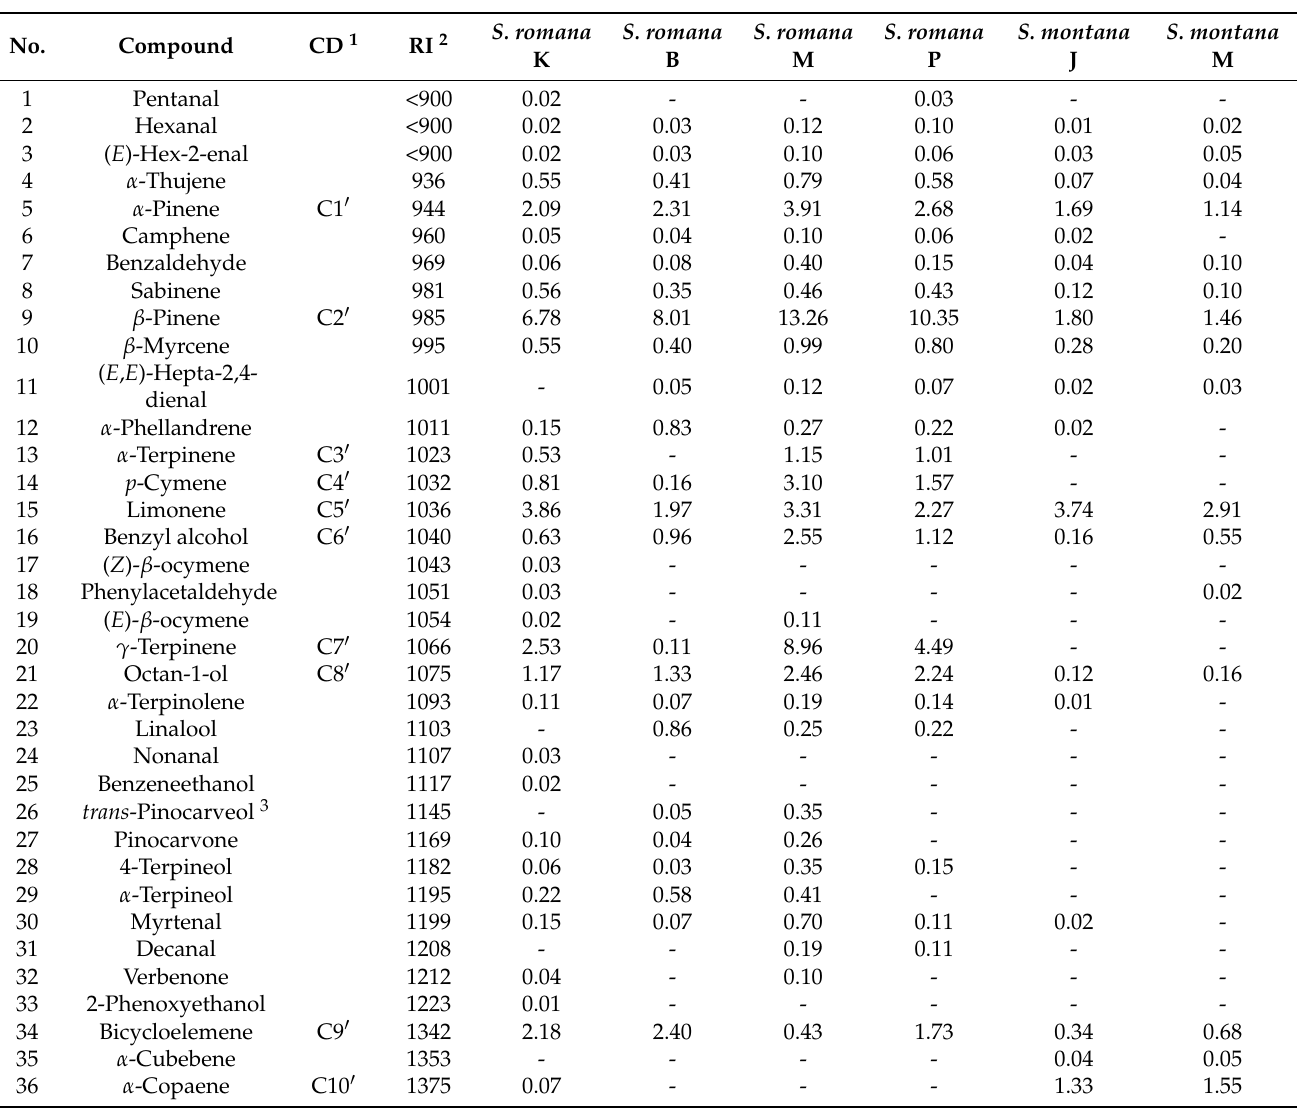
Table 2. Volatile organic compounds (VOCs) composition (%) of S. romana and S. montana obtained by HS-SPME/GC-MS with PDMS/DVB